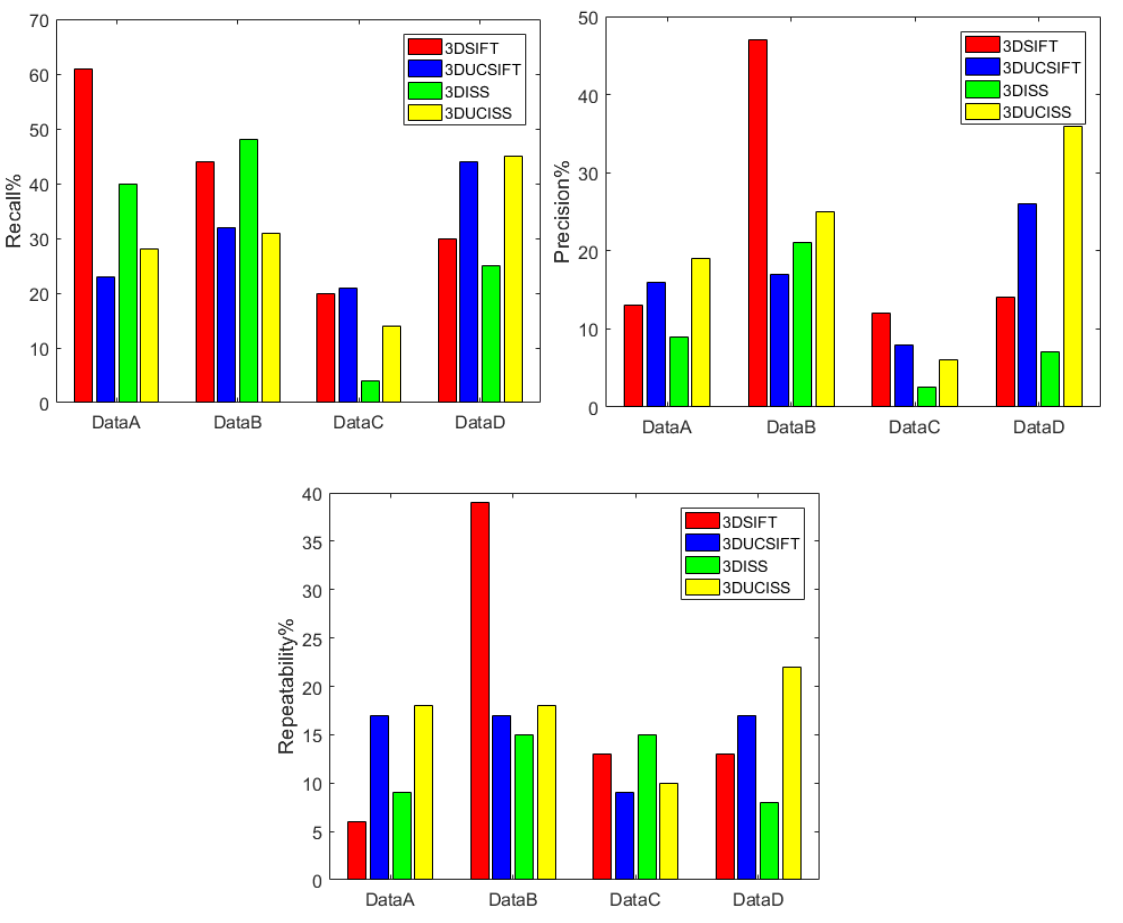
Figure 11. Results of Recall, Precision, and Repeatability criteria.